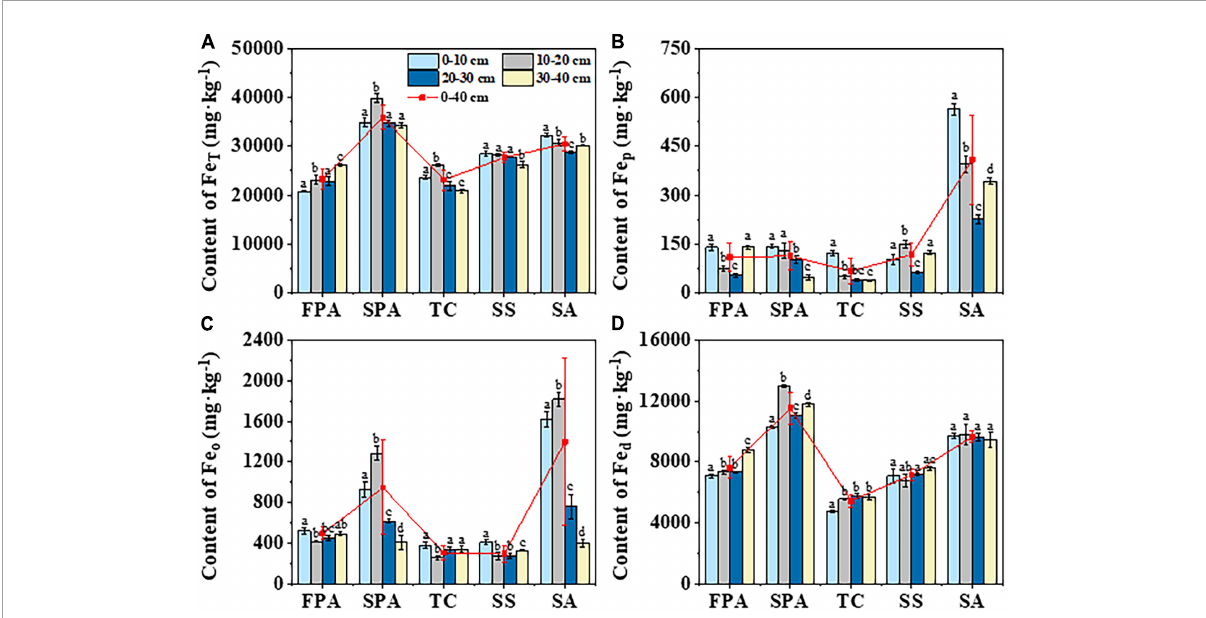
FIGURE3 Distribution characteristics of Fe T (A) , Fe p (B) , Fe o (C) and Fe d (D) in soils of different communities. Fe T , total iron; Fe p , complexed iron; Fe o , amorphous iron; Fe d , free iron. Lower letters represent significant differences across depths of the same site ( p < 0.05).